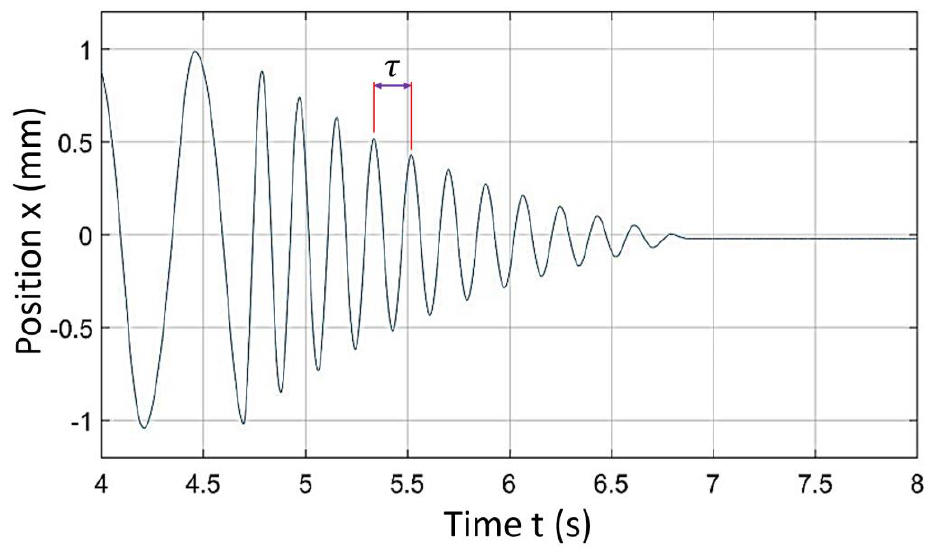
Figure 13. Comparison of theoretical, FEA and experimental force deflection.